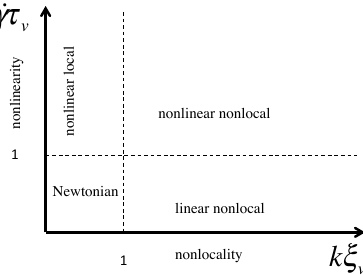
Figure 4. Diagram showing the rheological flow regimes for fluids exhibiting nonlocal shear pressure response under steady flow conditions. The horizontal axis represents the degree of nonlocality exhibited by the flow, which is controlled by the product of the characteristic spatial frequency (or wavenumber) of the flow k and the viscous correlation length of the fluid ξ v . The vertical axis represents the degree of nonlinearity of the flow, controlled by the product of the characteristic strain rate ˙ γ and the viscoelastic relaxation time τ v